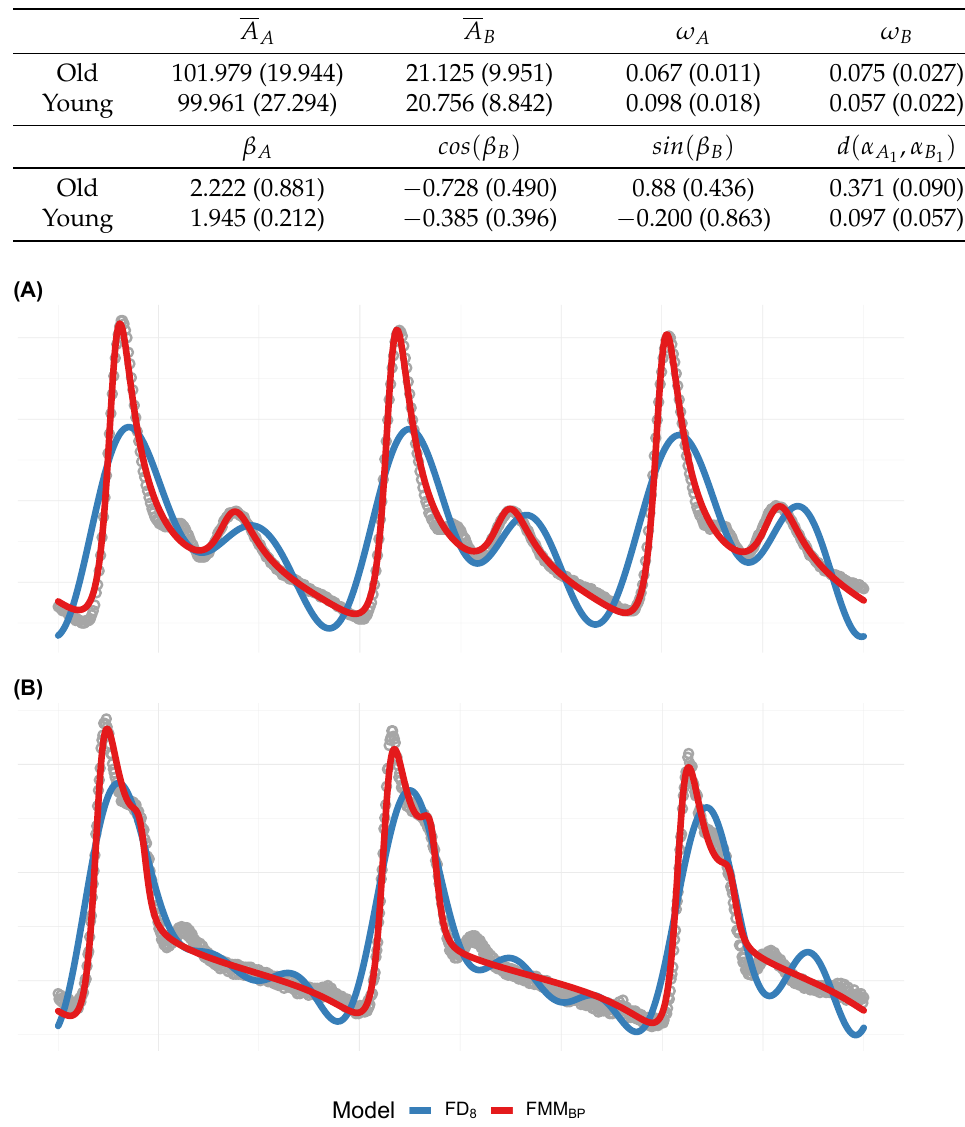
Figure 4. Fantasia BP signals and fittings. ( A ): BP signal (grey open circles), FMM BP (blue line) and FD 8 (red line) predictions, for a female of 27 years old. ( B ): BP signal (grey open circles), FMM BP (blue line) and FD 8 (red line) predictions, for a male of 70 years